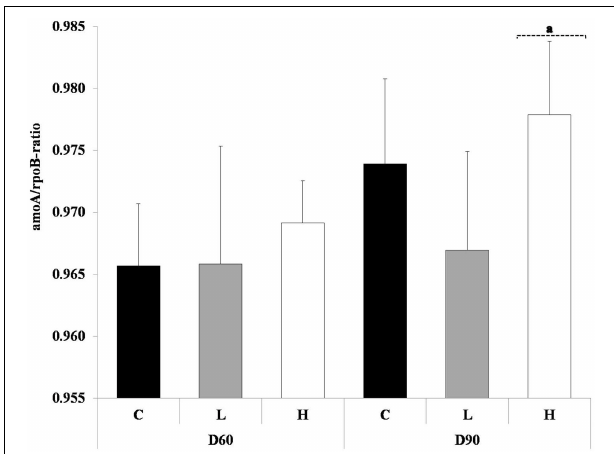
FIGURE 4 | Displayed are the ratios of amoA and rpoB at day 60 and 90. The different treatments are shown as C, control; L, Low; H, High. Ratios are shown as average + 1 standard deviation ( n = 5 ). Square bracket with dashed line and letter a refers to treatment within a sampling occasion significant different on the 0.1 level, compared to L treatment